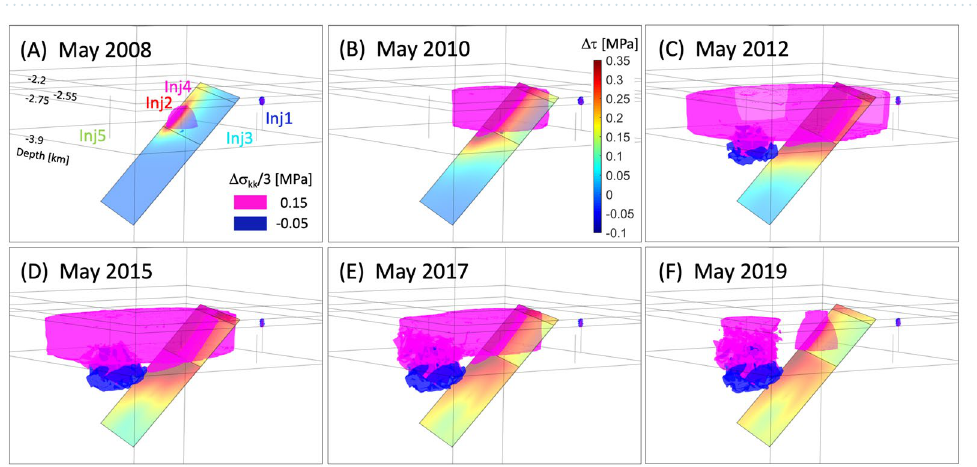
Figure 4. ( A – F ) Spatial distribution of isosurfaces of mean stress changes ( �σ kk / 3 ) in the domain and total Coulomb stress change ( �τ ) along the WVF plane at six time steps. Magenta and blue isosurfaces represent positive and negative mean stress changes of 0.15 and − 0.05 MPa,